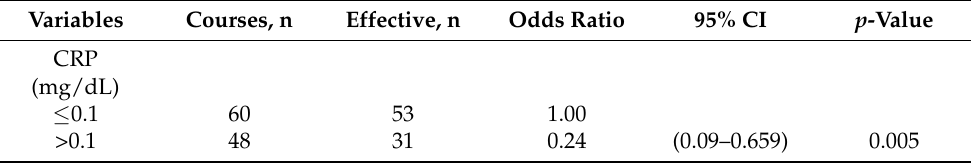
Figure 2. ( a ) Comparison of CRP levels between the effective and ineffective groups. The Mann– Whitney U test was used. ( p < 0.01) ( b ) Receiver operating characteristic curves of CRP with effectiveness. ( c ) Changes in CRP over time. Table 2. Univariable logistic regression models to evaluate the impact of CRP on the effect of oral iron therapy.